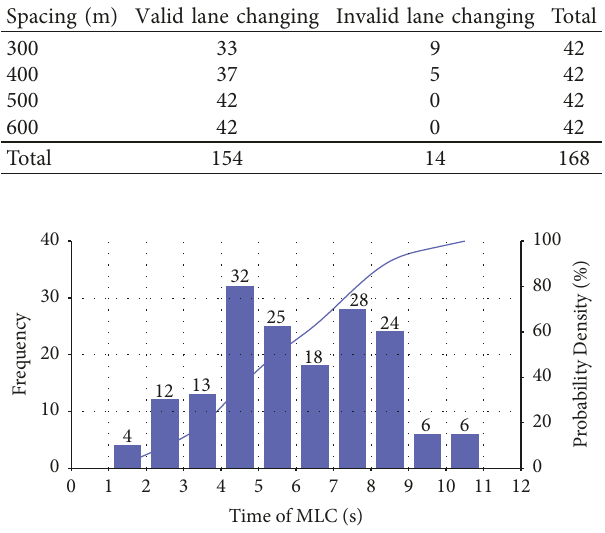
Table 2: Statistics of lane-changing data.